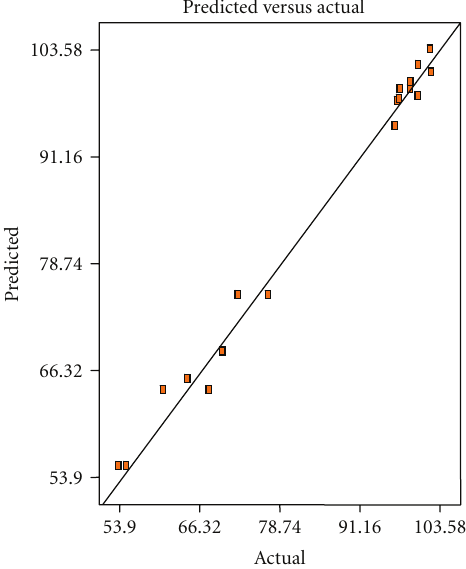
Figure 4: Predicated versus actual plot of Y